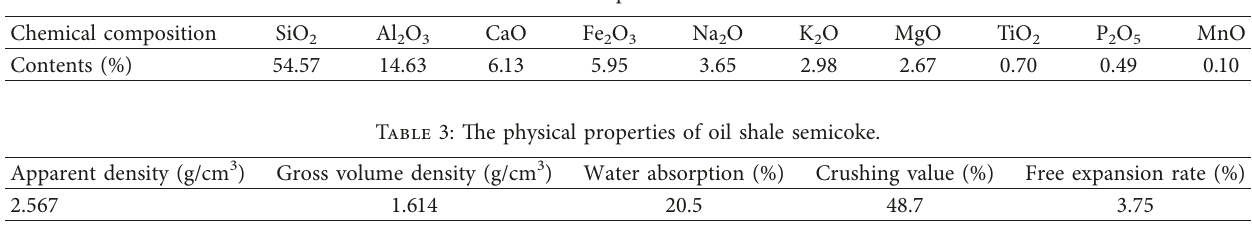
Table 2: The chemical composition of oil shale semicoke.